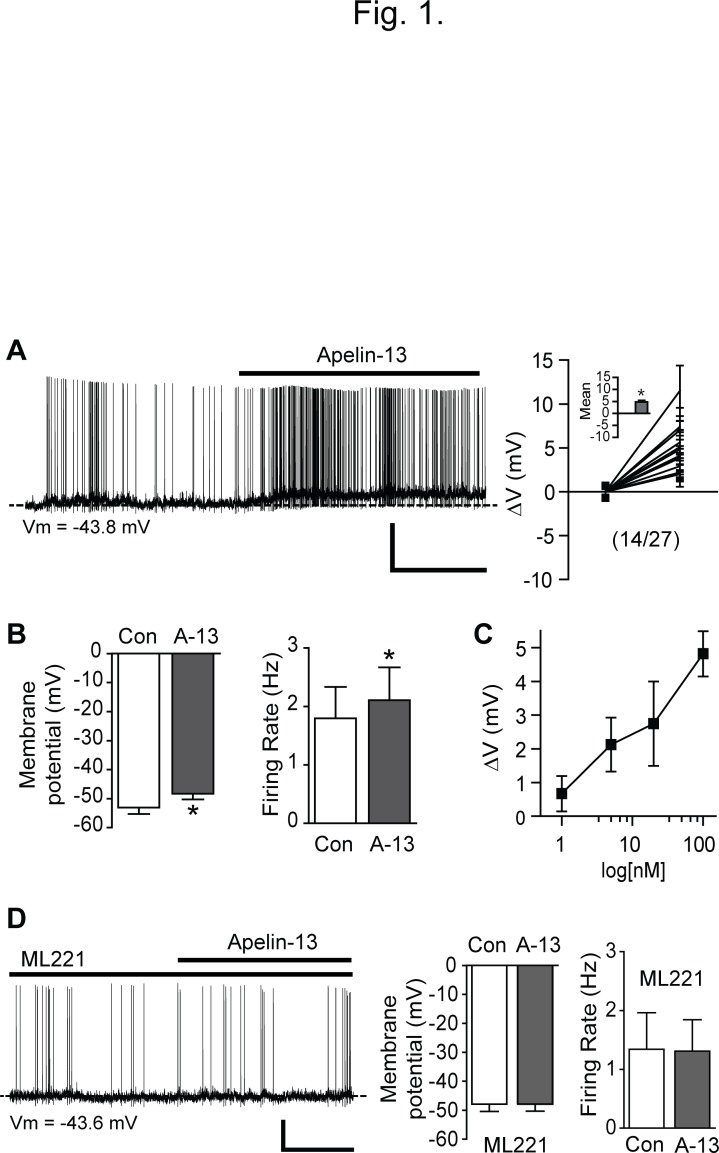
Apelin-13 depolarizes POMC neurons in the ARC.
(A) Representative recording sample of the whole-cell membrane potential before, during and after treatment with apelin-13 after having blocked ionotropic glutamate and GABA receptors (left panel). Treatment with apelin-13 (100 nM) induced a depolarization and increased the firing rate of POMC neuron (right panel; mean change in membrane potential: +4.8 ± 0.7 mV, n = 14 neurons, p < 0.05). Scale bar: 20 mV, 2 min. (B) Pooled data of membrane potential and firing rate of POMC neurons with apelin-13 (A-13) (mean membrane potential: before -53.1 ± 2.2 mV vs. after -48.3 ± 1.9 mV, n = 14 neurons, p < 0.05; mean firing rate: before 1.8 ± 0.5 Hz vs. after 2.1 ± 0.6 Hz, n = 9 neurons, p < 0.05). (C) Apelin-13 causes a concentration-dependent depolarization of POMC cells. Depolarization by apelin-13 was determined at 1, 5, 20 and 100 nM in 6, 9, 6 and 14 neurons, respectively. (D). Representative whole-cell recording sample of the electrophysiological effect of apelin-13 in the presence of the APJ receptor antagonist ML221 (20 μM; left panel). Under these experimental conditions, POMC neurons did not respond to apelin-13 (middle and right panels; n = 11 neurons, p > 0.05). Scale bar: 20 mV, 2 min.